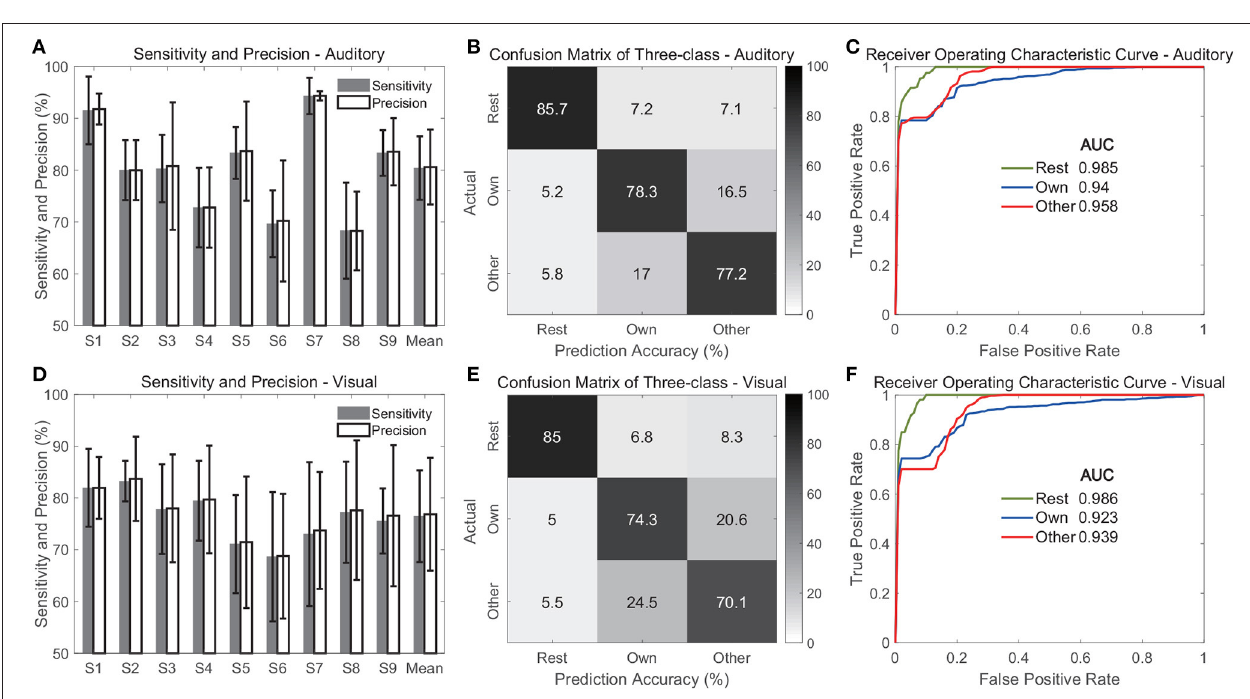
FIGURE 11 | Classification performance for three classes including rest state. (A–C) Show evaluation of the auditory modality. (D–F) Show evaluation of the visual modality. Specifically, (A,D) show the sensitivity and precision. In these two sub-figures, the bars indicate the mean across three classes, and the error bars indicate the standard deviation across classes. (B,E) Show the average confusion matrices across subjects, and (C,F) show the average receiver operating characteristic curves of three classes across